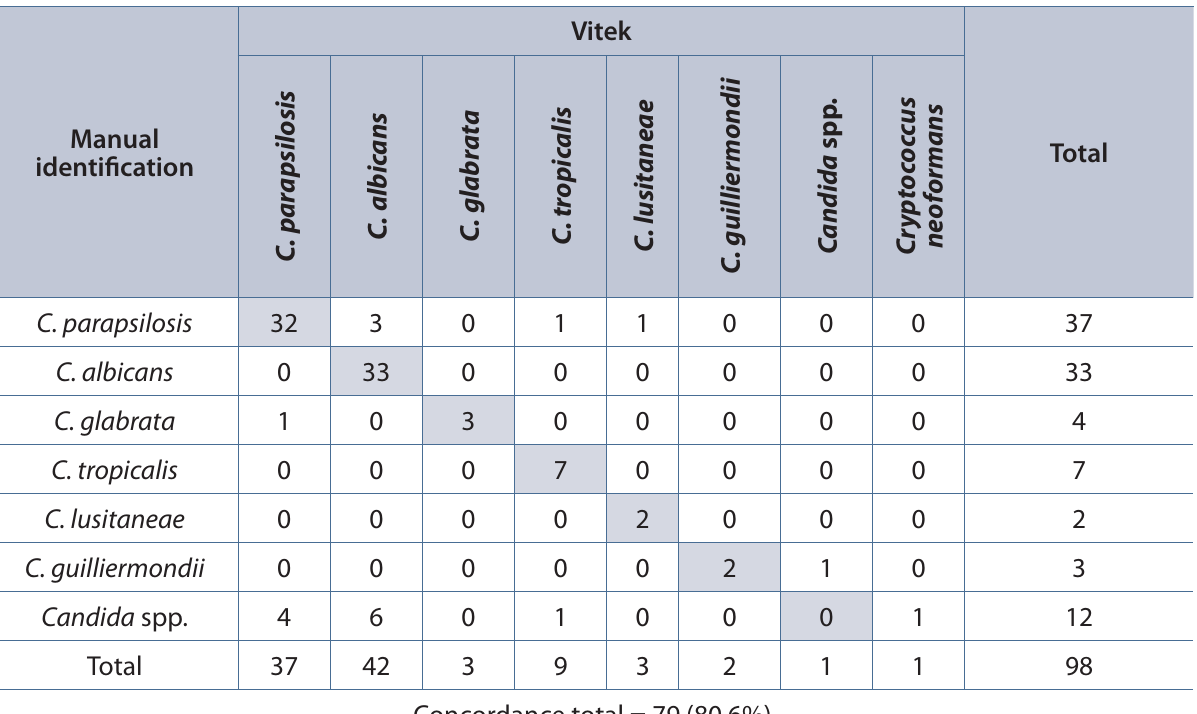
Table 1. Comparison between manual and automated (Vitek I) identification